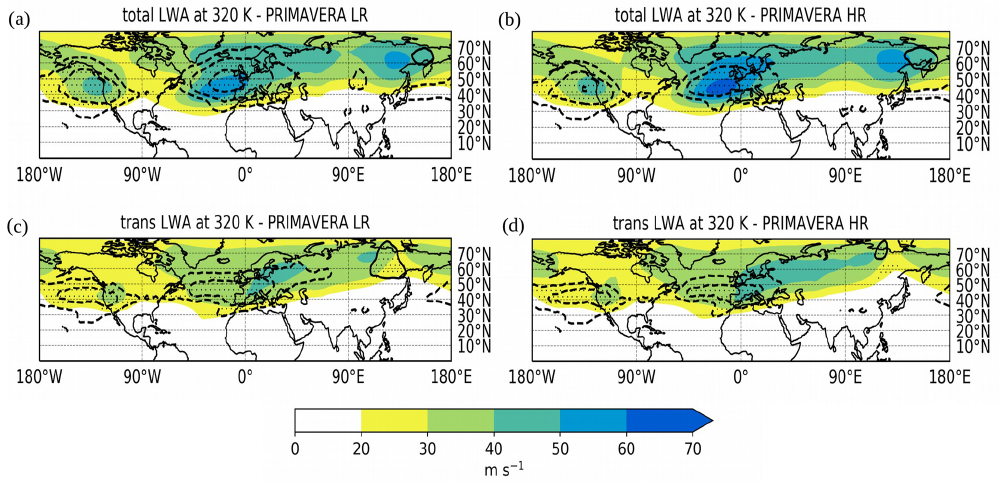
Figure 2. Multimodel mean of total LWA at 320K for PRIMAVERA LR and HR (panels a and b ) and for transient LWA (panels c and d ). Black contours are the multimodel mean bias with respect to ERA5 (contour intervals every 5ms − 1 ; negative values are dashed). Stippling denotes the grid points in which the LWA bias is significant (i.e the bias is larger than the standard error in